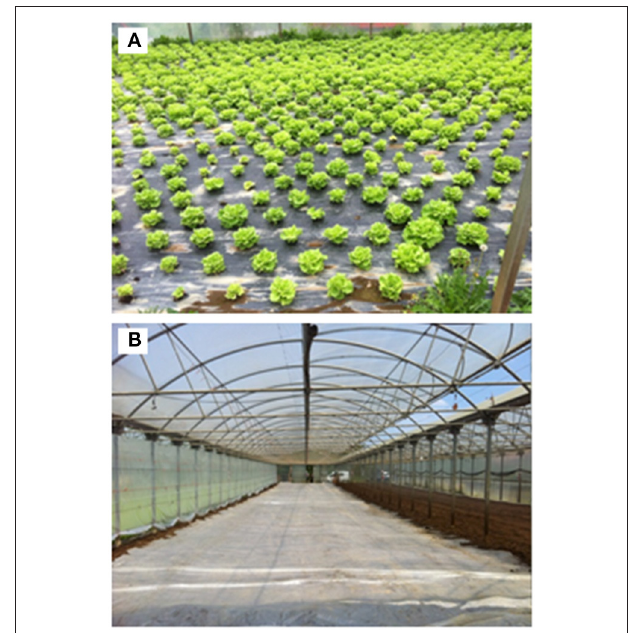
FIGURE 1 | (A) Lettuce crop damaged by M. incognita nematode in the treated greenhouse. (B) View of biodisinfested and controls plots.